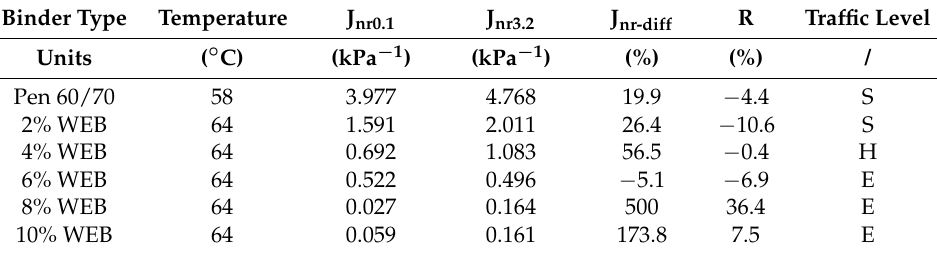
Table 3. Multiple stress creep recovery (MSCR) test results with DSR at 64 ◦